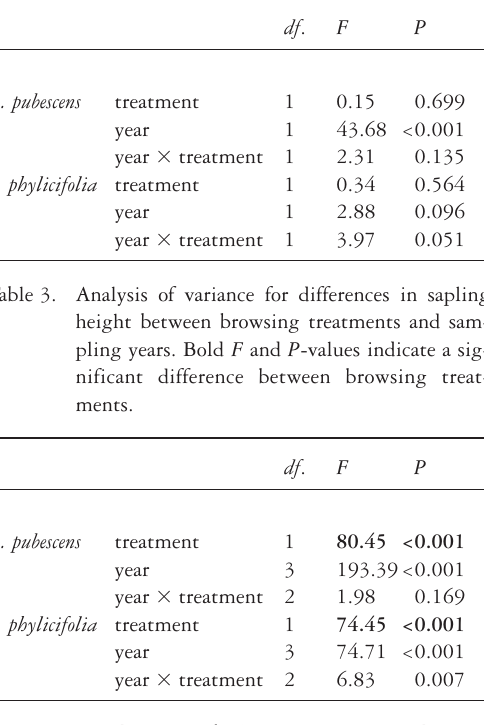
Table 2. Analysis of variance with repeated measures for differences in seedling (plants < 10 cm high) densities between browsing treatments and sampling years.